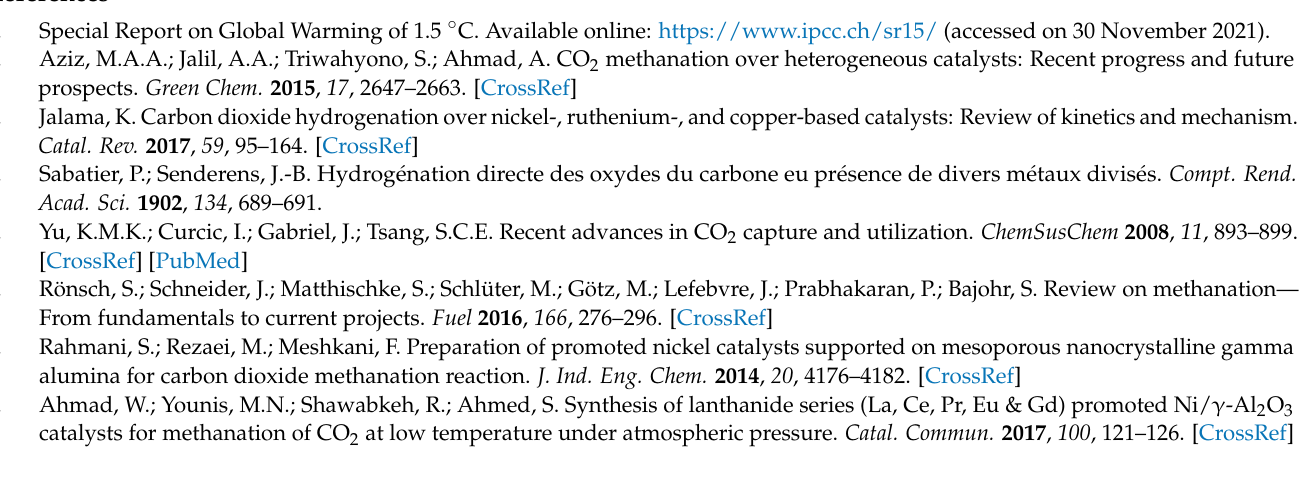
Figure S2: X-ray diffraction patterns of catalysts after reduction (a–c). Figure S3: CO 2 conversion (a,c,e) and selectivity to CH 4 (b,d,f) of cerium and tungsten-promoted, alumina-supported nickel catalysts in CO 2 methanation reaction. Figure S4a: Survey XPS scans of Ni40-Al 2 O 3 catalyst after calcination (-calc.), activation in hydrogen (-H 2 ), and CO 2 methanation reaction (-H 2 /CO 2 ).